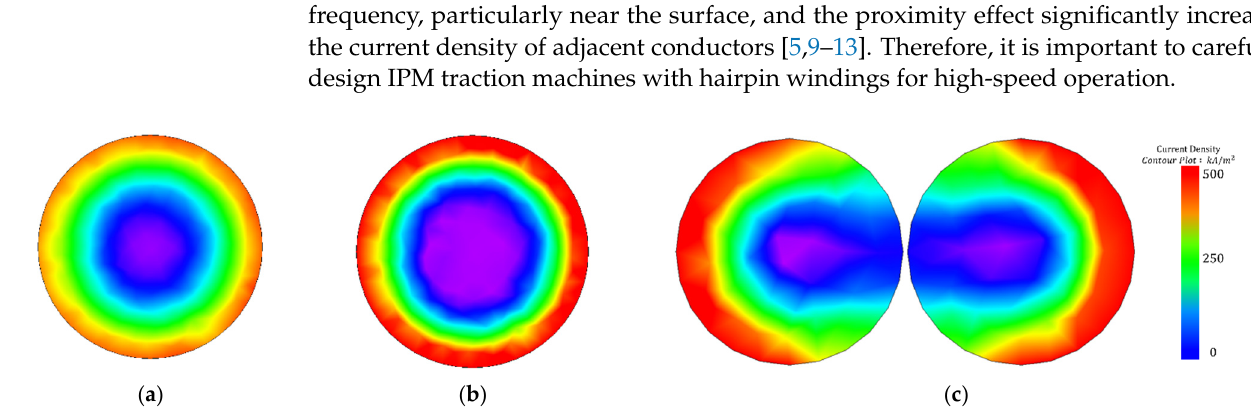
Figure 1. Current density distribution within a conductor(s) as a function of skin effects and proximity effects: ( a ) Single conductor at 20 Apk, 2 kHz; ( b ) Single conductor at 20 Apk, 4 kHz; ( c ) Two adjacent conductors at 20 Apk, 2 kHz.